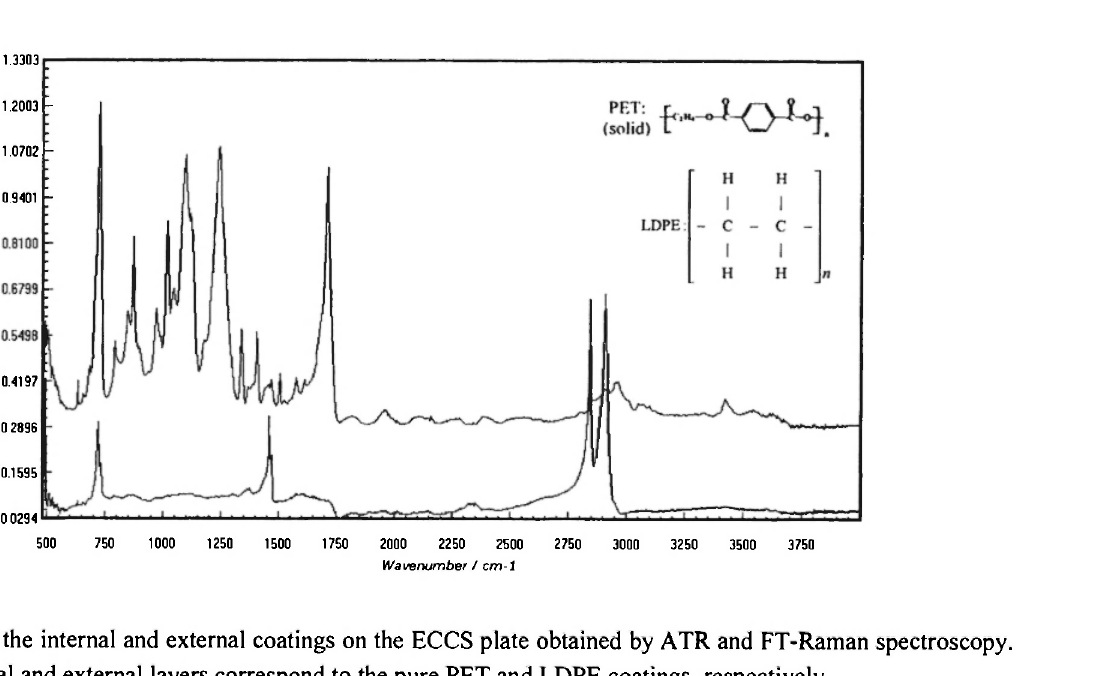
Therefore, the manufacturing of multilayer plates with both an amorphous and crystalline structure, from materials such as PET polymers, allows the synergic combination of good adhesion and corrosion resistance to degradation, which is useful in food canning. The porosity trial, to measure the surface continuity of the protection film, can be used as an index to evaluate corrosion resistance of the PET polymer rolled over the ECCS plate. Also, the low current values are indicative of an adequate thickness of the biaxial- oriented PET layer, which is the result of the PET re- Fig. 7: Measurement of current vs. time to evaluate the crystallization during the manufacturing process of the continuity of the polymer coating on the ECCS ECCS plate.